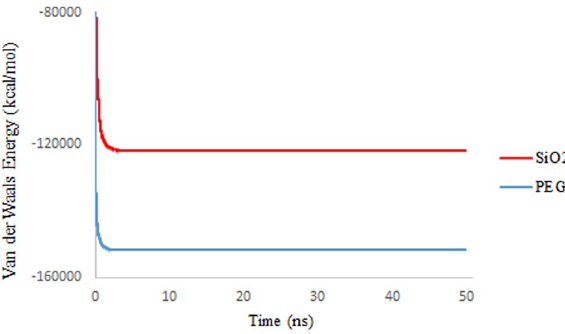
Figure 12. Van der Waals energies between 3TC and SiO 2 (red), PEG (blue).